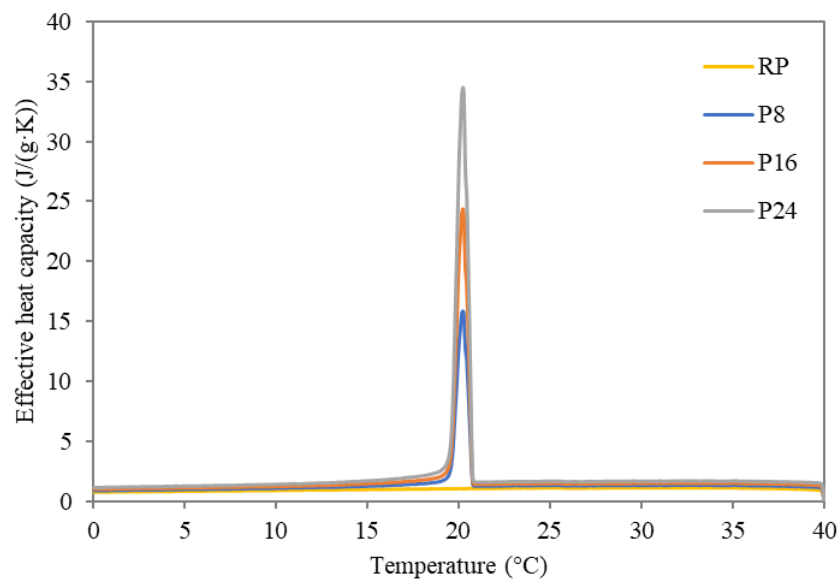
Figure 3. Temperature dependent effective heat capacity of studied FSPCM plasters during cooling.